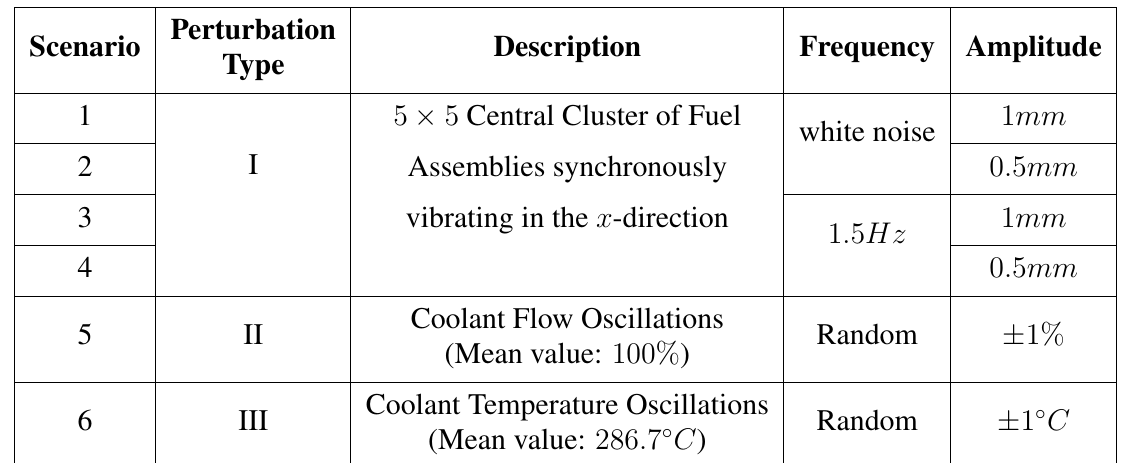
Table 1: Perturbation types & scenarios considered in the